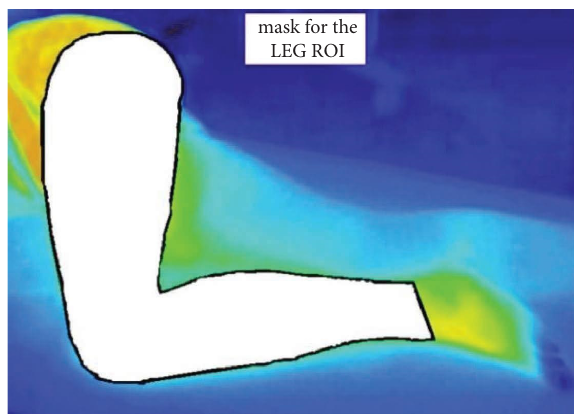
Figure 3: Te mask applied for the ROI determination in a representative thermogram. Table 1: Te SP test ® results of the healthy subjects depend on the latent trigger points